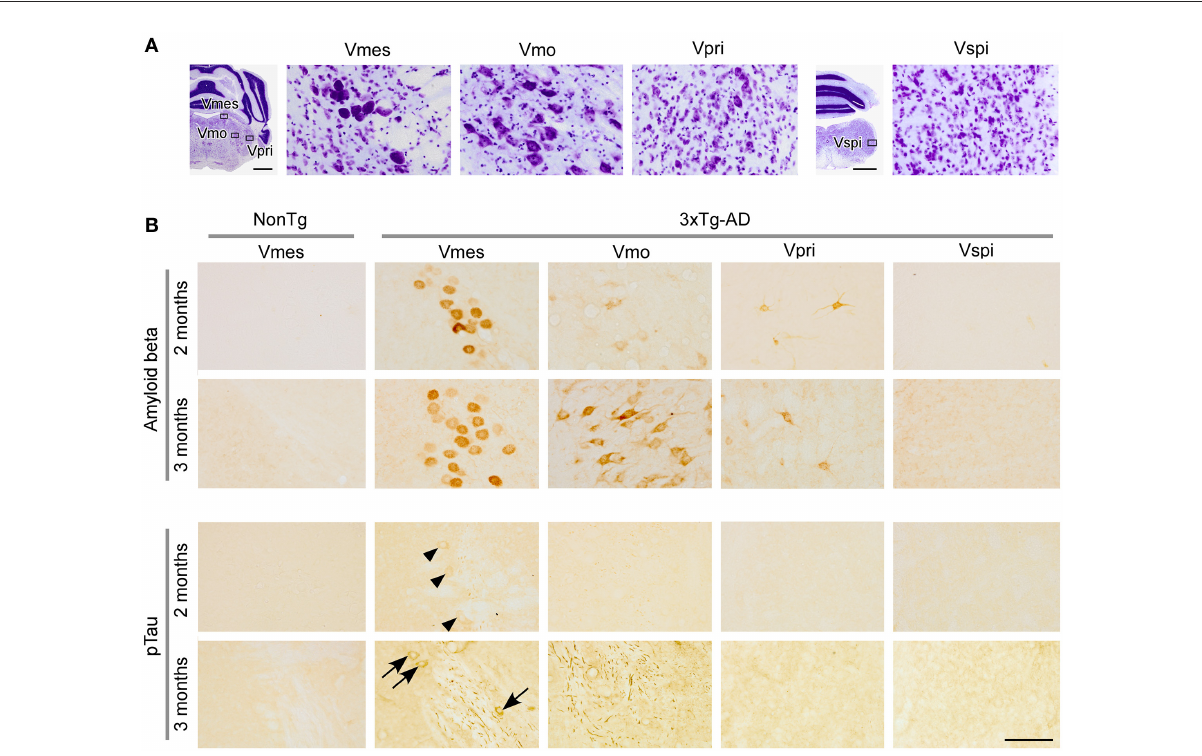
FIGURE2 AD pathology in the trigeminal nuclei of 2- and 3-month-old 3 × Tg-AD mice. (A) Cytoarchitectonic structures of the trigeminal nuclei; the mesencephalic trigeminal nucleus (Vmes), trigeminal motor nucleus (Vmo), principal sensory trigeminal nucleus (Vpri), and spinal trigeminal nucleus (Vspi). (B) Intense A β immunoreactivity was observed in the Vmes and Vmo of 3 × Tg-AD mice. Weak A β immunoreactivity was also observed in the Vpri. In the Vmes of 2-month-old 3 × Tg-AD mice, p-tau weakly positive cell bodies (arrowheads) were observed; in 3-month-old 3 × Tg-AD mice, intense immunoreactivity to p-tau was observed in cell bodies (arrows) and axon fibers. In the Vmo, many p-tau-positive axon fibers (potentially derived from the Vmes) were observed. In NonTg mice, neither A β (human) nor p-tau immunoreactivity was observed. Scale bars: 1mm (A) and 100 µ m (in B ; applies to A Vmes , A Vmo , A Vpri , A Vspi , and